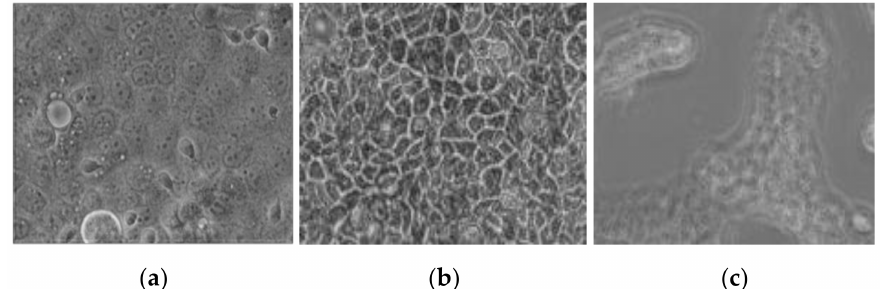
Figure 6. ( a ) Caco-2 monolayer incubated with Giardia intestinalis for 2 h without treatment ( b ) Caco-2 monolayer incubated with Giardia intestinalis after 24 h of microparticle addition, and ( c ) Caco-2 monolayer incubated with Giardia intestinalis after 24 h without treatment. (10 ×